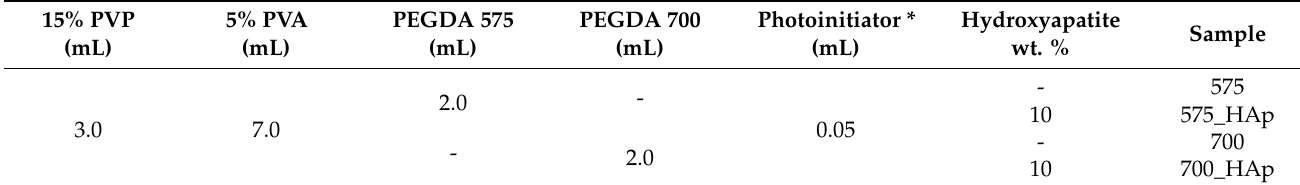
Table 3. The compositions of prepared composites.